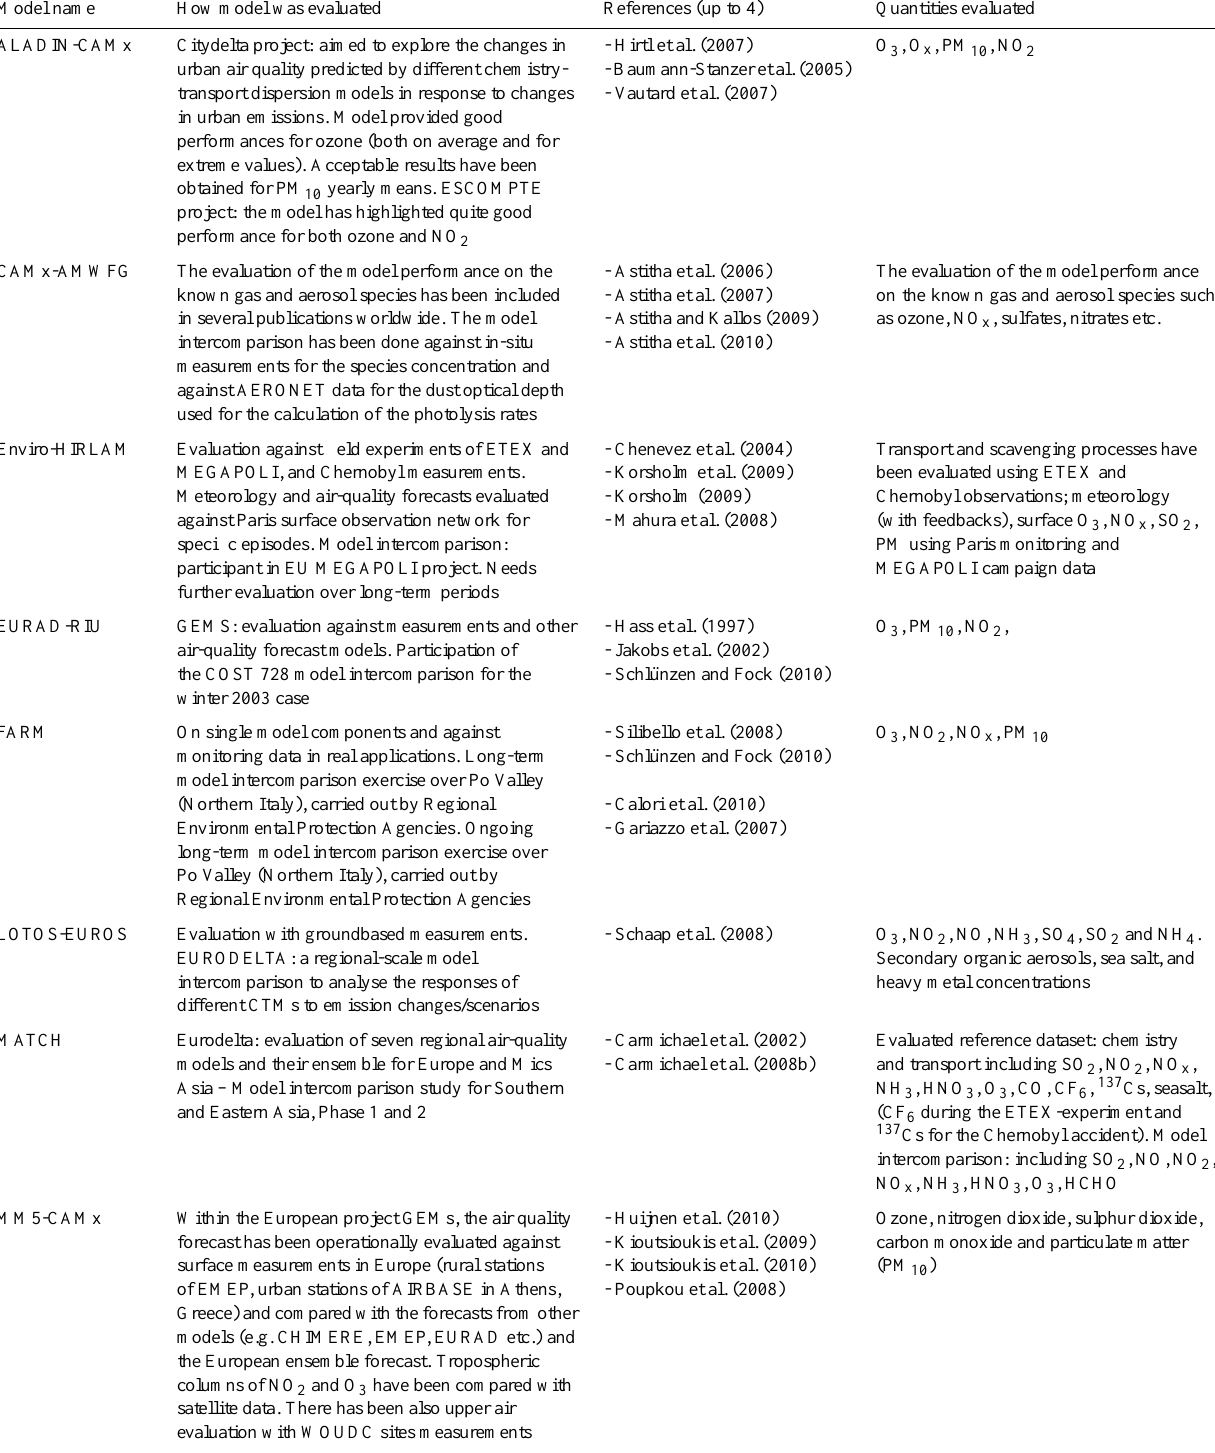
Table 10. A summary description of the evaluation of each CWF